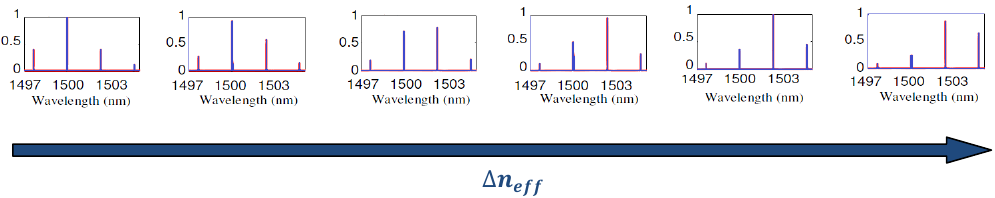
Figure 6. Transmittance spectrum of the proposed Vernier sensor for increasing values of